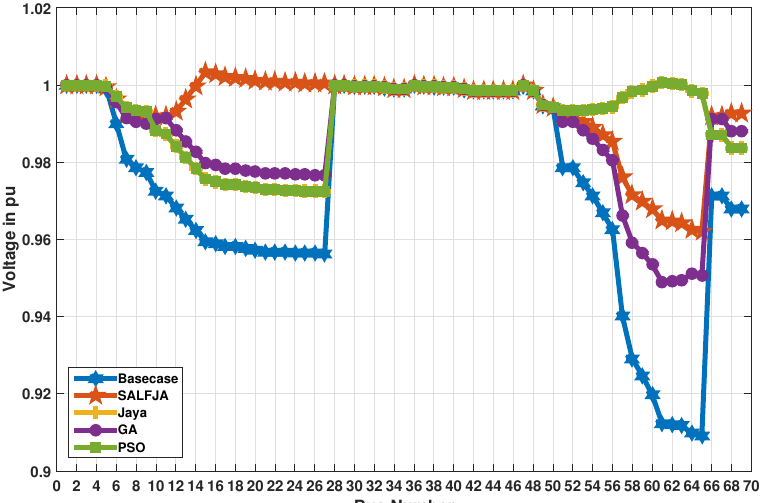
Figure 7. PG and E 69 bus system: Voltage